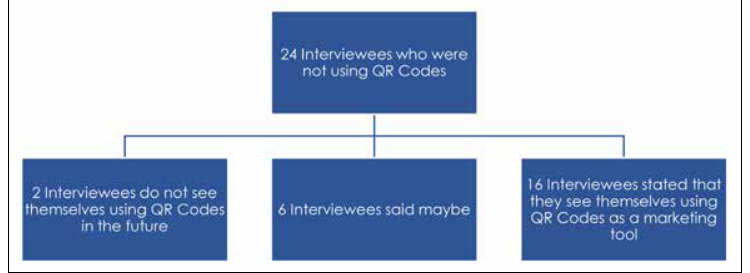
Figure 4: The reasons for some interviewees not using QR